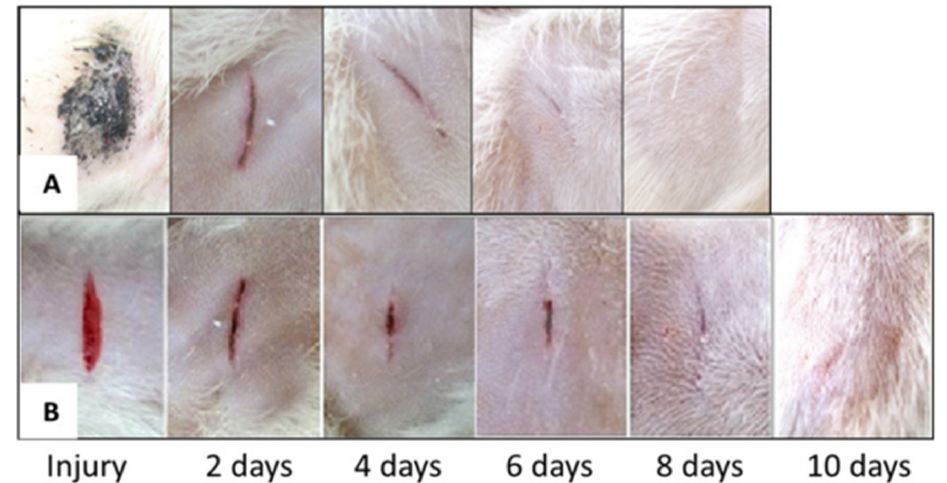
Figure 9. Dynamics of infected wound healing in rats. ( A ) Nanostructured carbonized sorbents were applied after injury. ( B ) Wound healing in the control group. Reprinted with permission from Ref. [45]. Copyright 2012, IntechOpen.